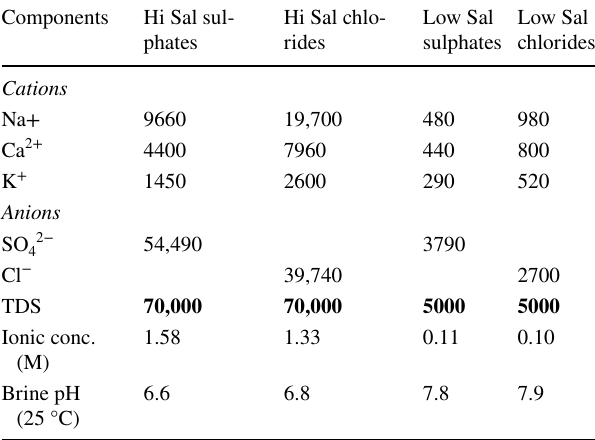
Bold showcases the concentrations of the brines used which is the foundation of